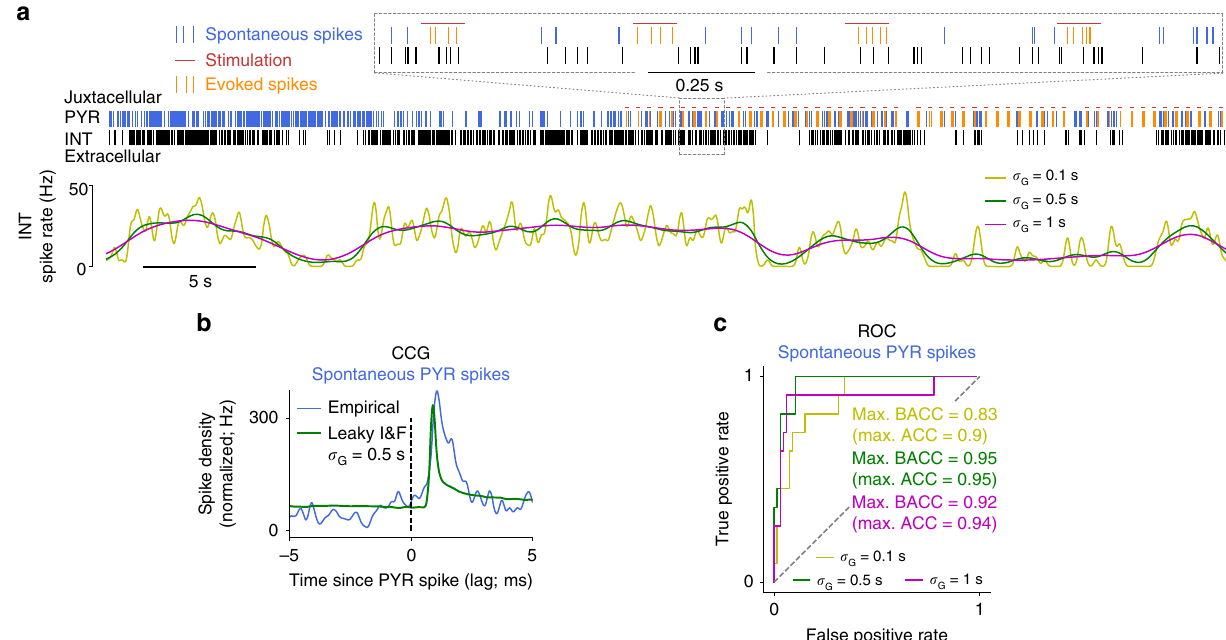
Fig. 6 Estimation results for synaptic couplings using in vivo data. a Example spike trains of a juxtacellularly recorded PYR and an extracellularly recorded INT, with stimulation pulses indicated (top panel). Instantaneous spike rate of the INT computed via kernel density estimation using a Gaussian kernel with width σ G as indicated (bottom panel). b CCG between spontaneous PYR and INT spike times and as computed from an I&F neuron fi tted to the INT spike train with estimated coupling strength and delay, corresponding to the example in ( a ). Note that synaptic coupling was modeled using delayed, transient pulses. Method 1a was used for parameter estimation. c ROC curves across 78 PYR-INT pairs using the spontaneous PYR spikes (up to 1000 per pair) for three different values of σ G . Maximal (balanced) accuracy values are